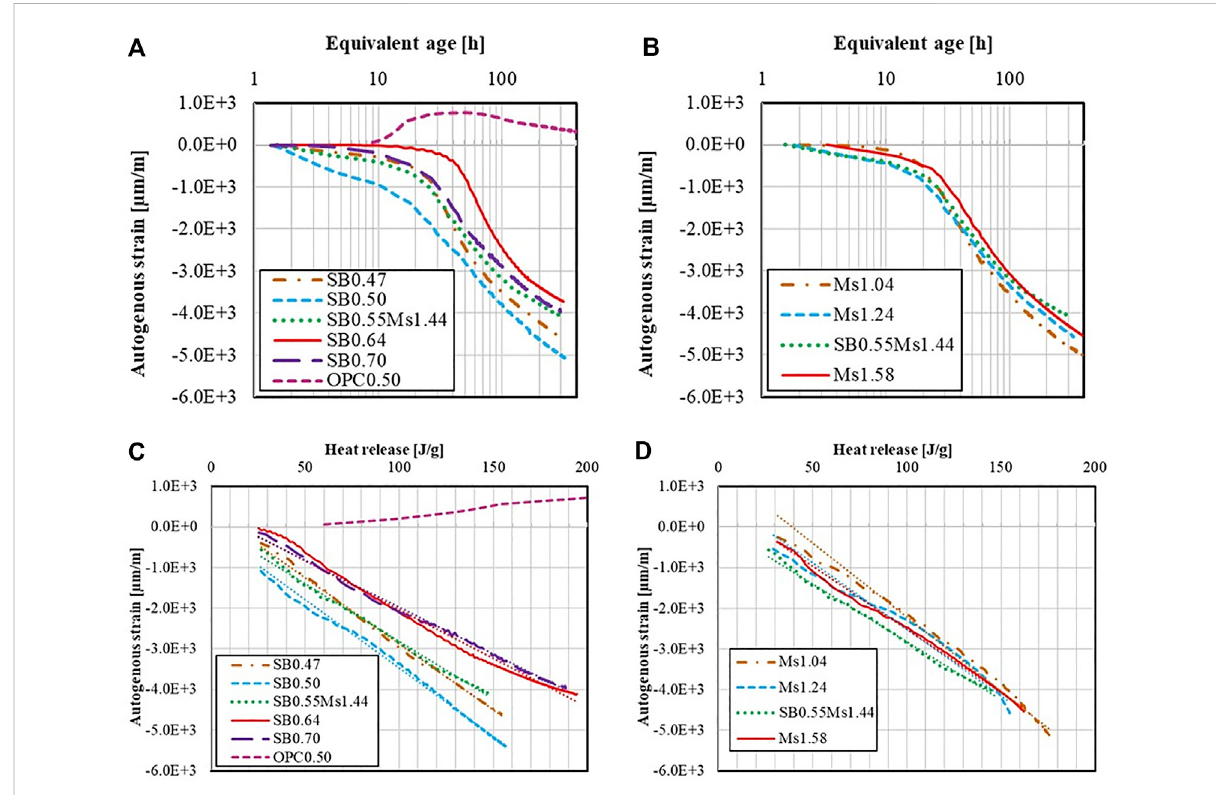
FIGURE 6 Autogenous strains of AASF pastes as a function of the equivalent age with different S/B (A) and with different M s (B) ; and as a function of the cumulative heat with different S/B (C) and with different M s (D) .